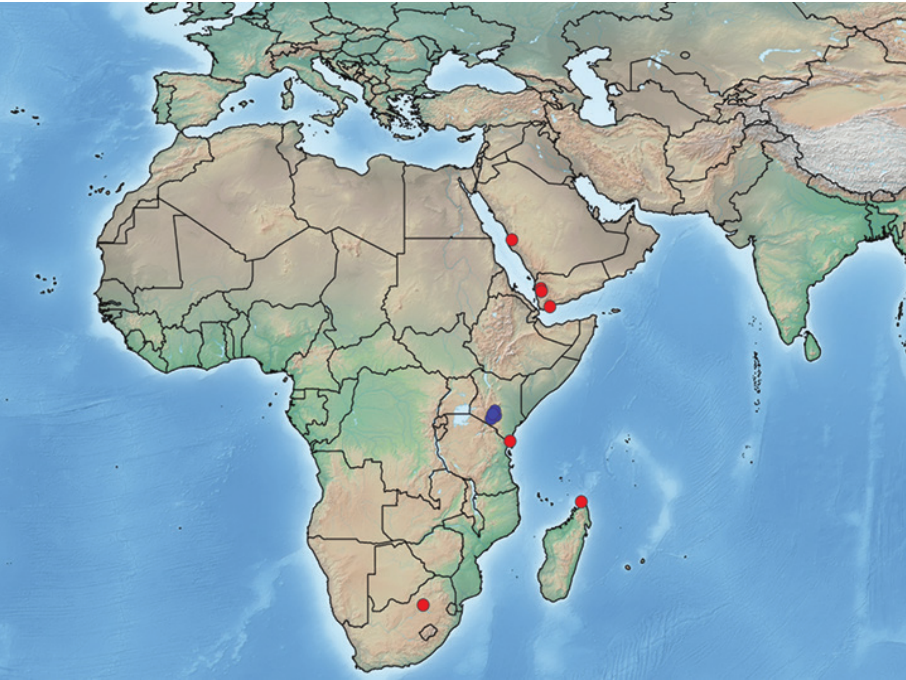
Figure 3. Known distribution of Cotesia icipe in the Afrotropical region. Blue dots show distribution based on specimens of the type series (Kenya), red dots show distribution based on specimens with DNA barcodes matching those of the Kenya